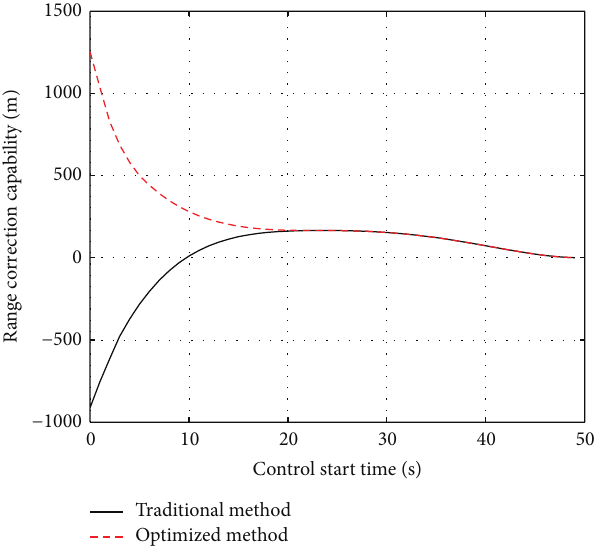
Figure 10: Contrast of range correction capability with traditional method and optimized